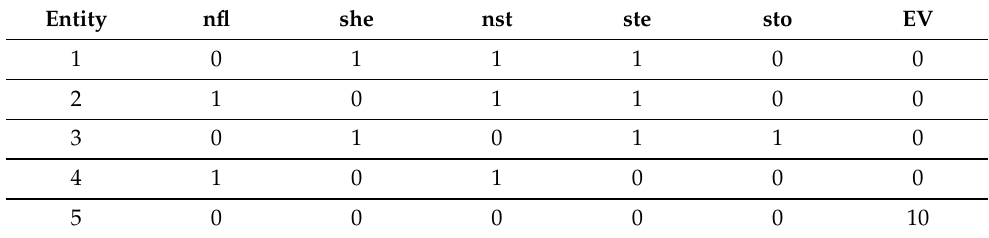
Table 4. Configuration of the community in Example 3.